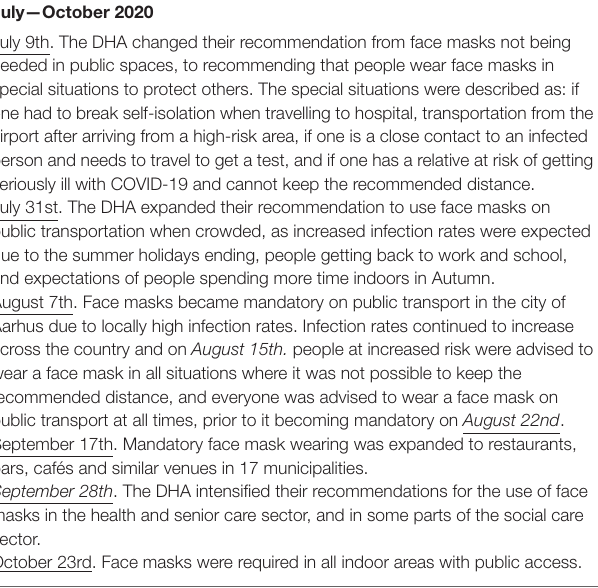
TABLE 1 | Danish face mask recommendations and regulations, July–October